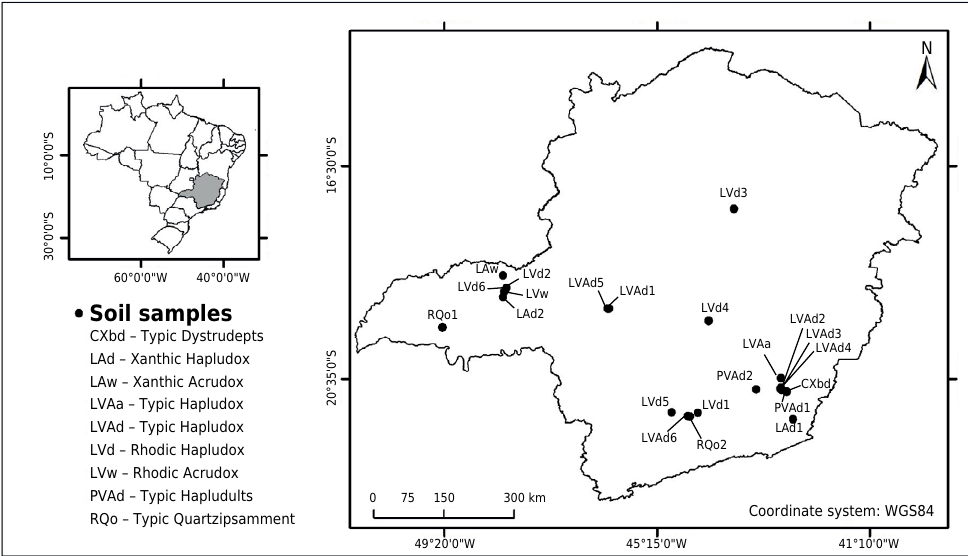
Figure 1. Soil sampling sites across the Minas Gerais State,